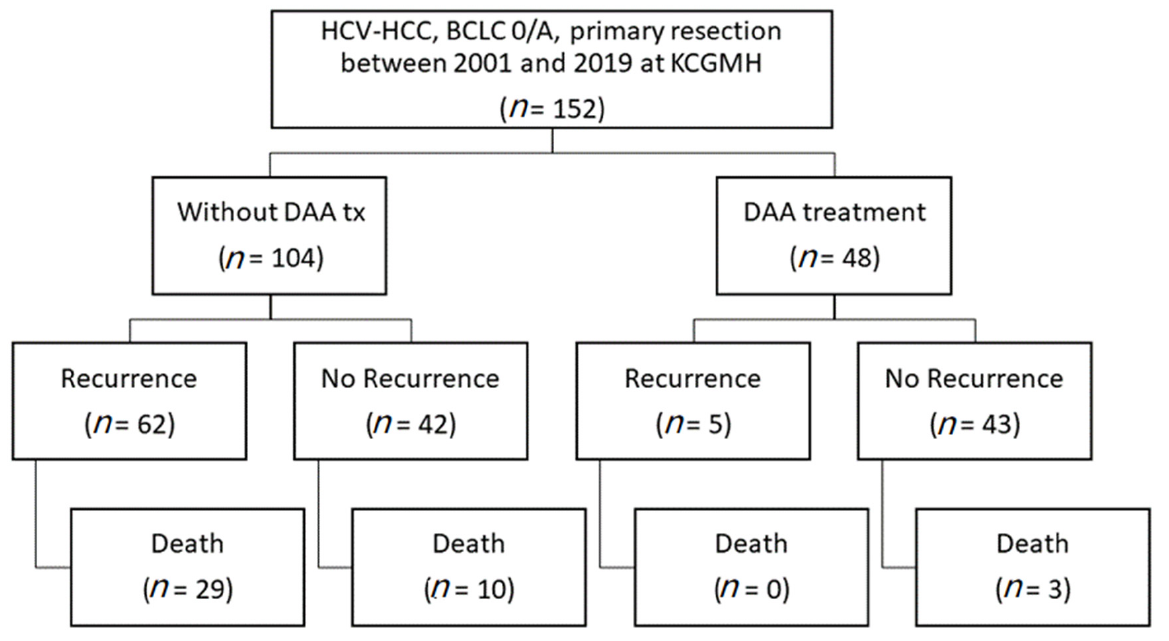
Figure 1. Patient-selection flow diagram .